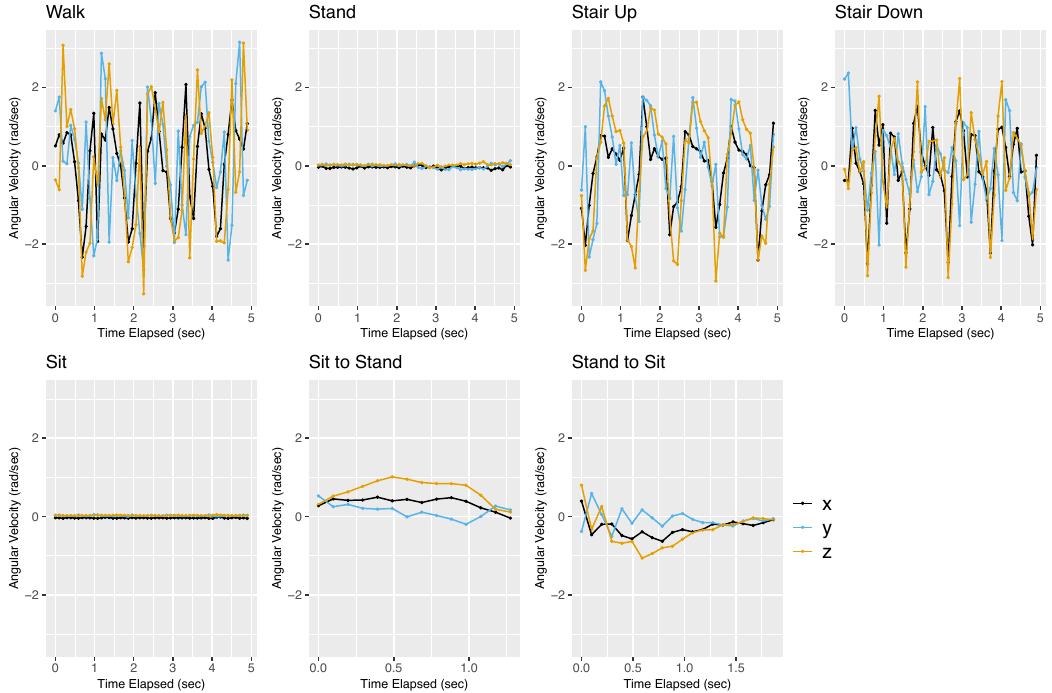
Figure 2. Gyroscope training data for participant 1. This figure shows the gyroscope training data for participant 1. The gyroscope measures the angular velocity of the smartphone projected onto the x , y , and z axes. The angular velocity data are measured in units of radians per second (rad/s). The x -axis is shown in black, the y -axis in blue, and the z -axis in